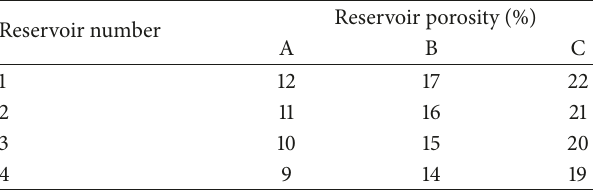
Table 6: The values of reservoir porosity.